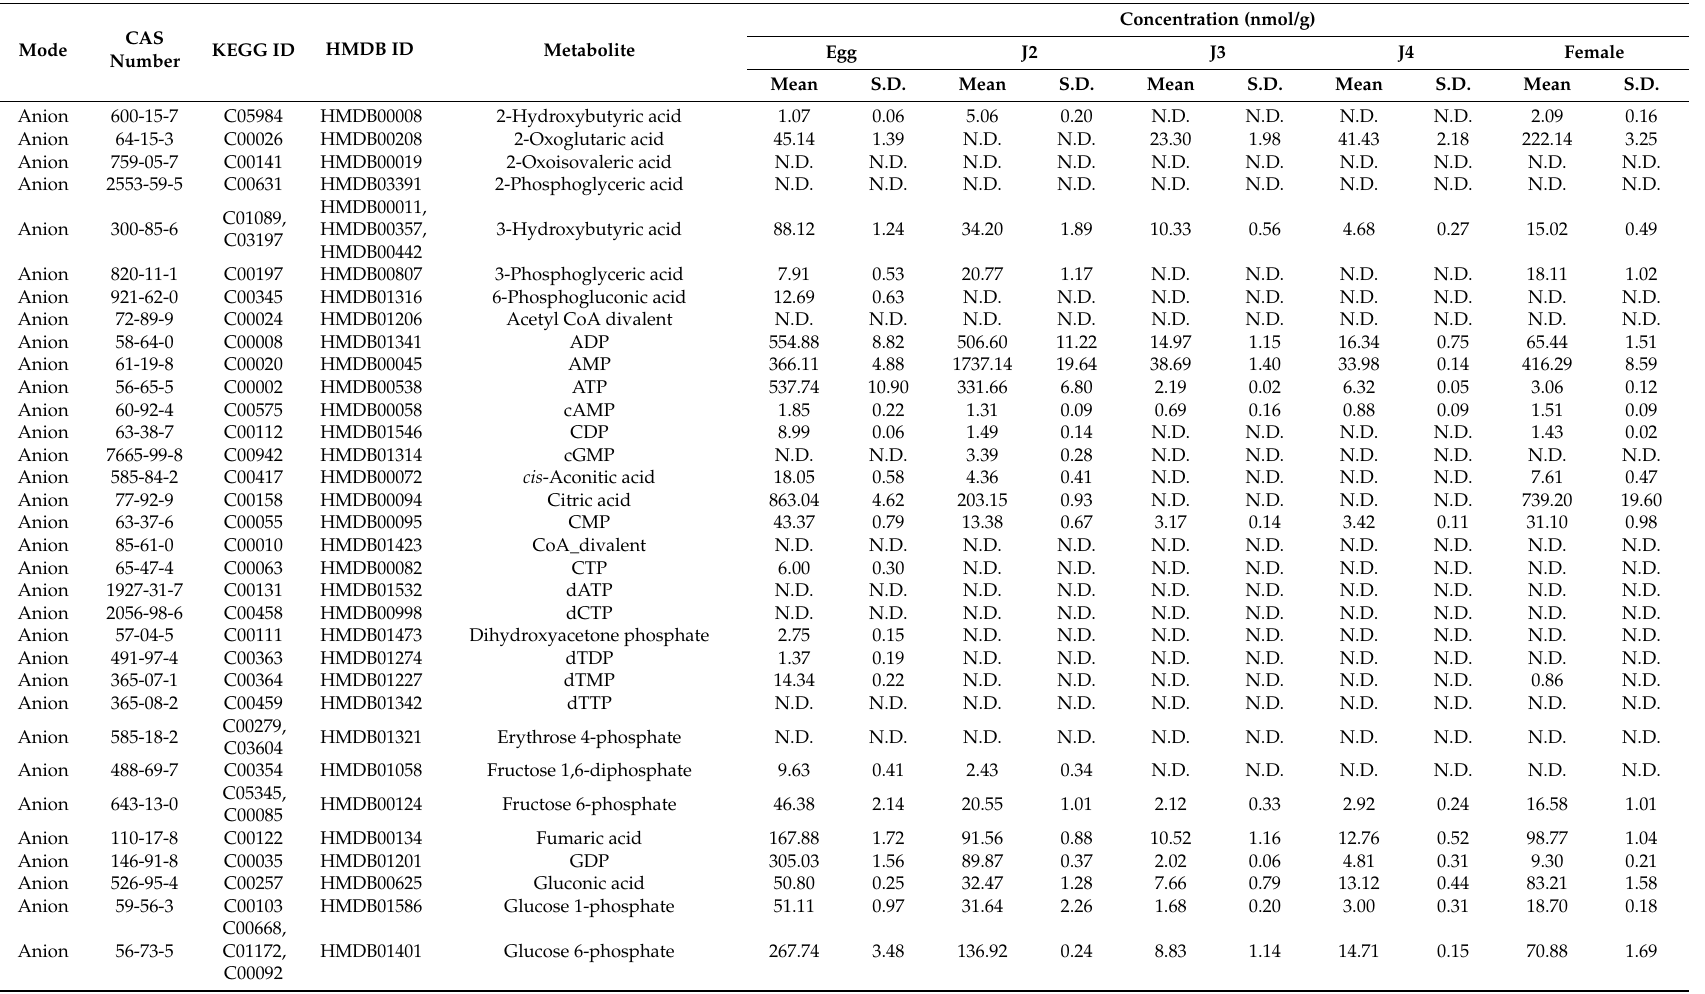
Table 2. Quantitative estimation of metabolites at various stages of the root-knot nematode life